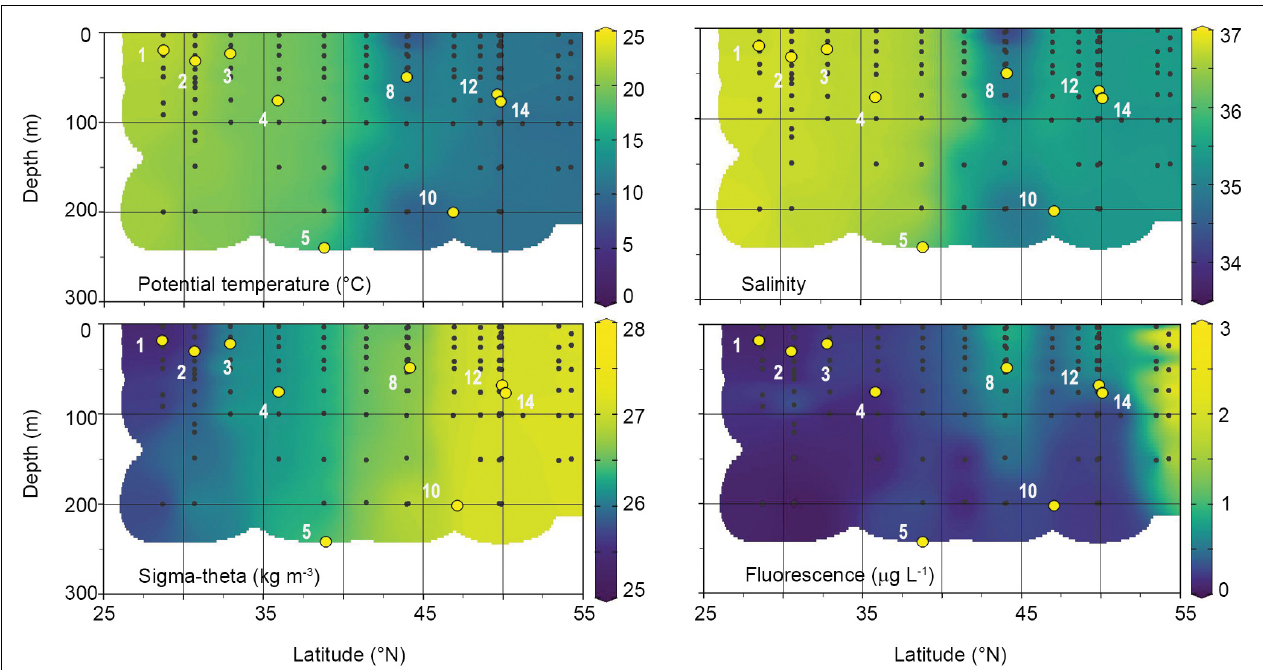
FIGURE 2 | Physical and chlorophyll fluorescence characteristics of the water column during the April 2018 Leg 8 NICO expedition. Black dots represent individual sampling points. White numbers are station numbers where modified dilutions experiments were performed. Yellow points indicate MLD of